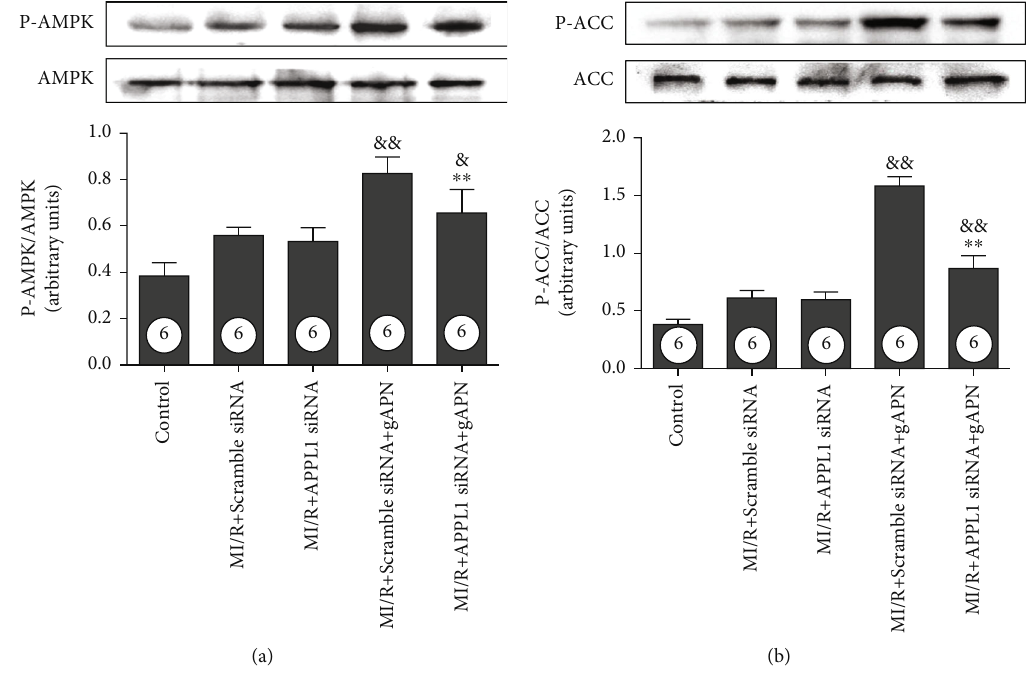
Figure 4: Inhibition of APPL1 expression blocked gAPN ’ s phosphorylation of the AMPK-ACC axis.